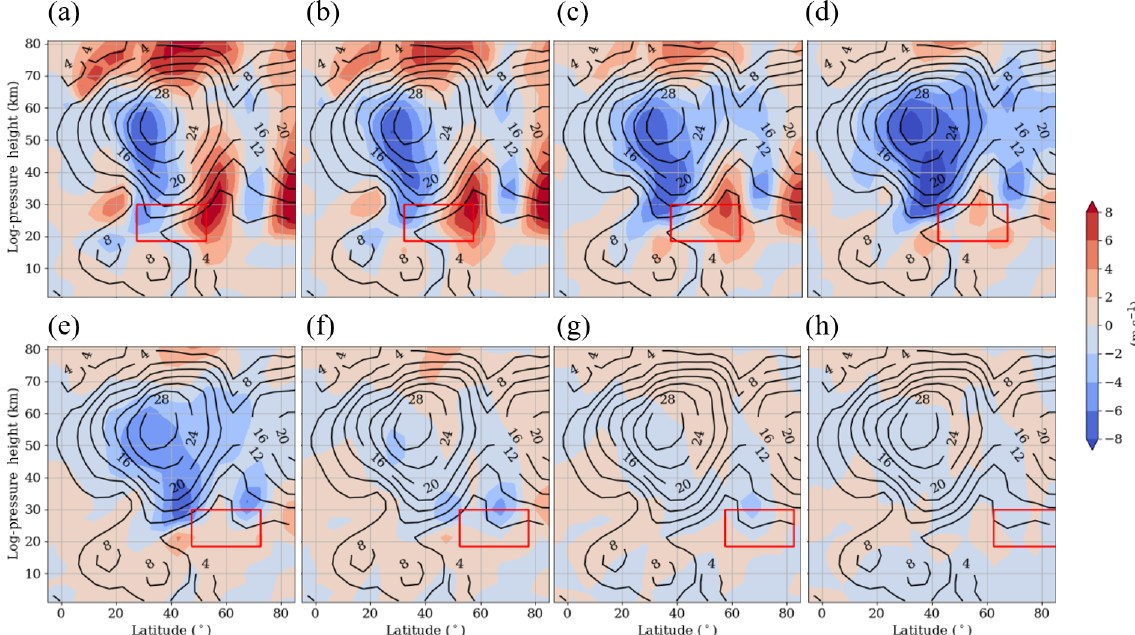
Figure 6. Zonal mean SPW 1 amplitude extracted from the zonal wind as the difference between the H1–H8 simulations (a–h) and the reference simulation. The colors indicate the difference between the simulations, and the contour lines show the zonal mean SPW 1 amplitude of the reference simulation. Figures represent the last 30d of the simulations. The position of each GW hotspot is represented by a red